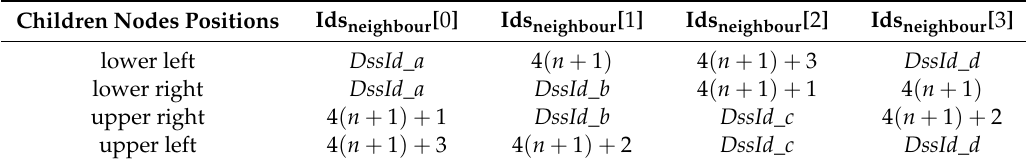
Table 1. Calculate values of Ids neighbour for children nodes.